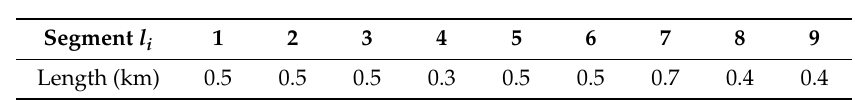
Figure 6. Boarding and alighting passenger volume. Table 3. Length of Segment Table 3. Length of Segment l i ( i ∈ 1, 2, . . . , 8 )